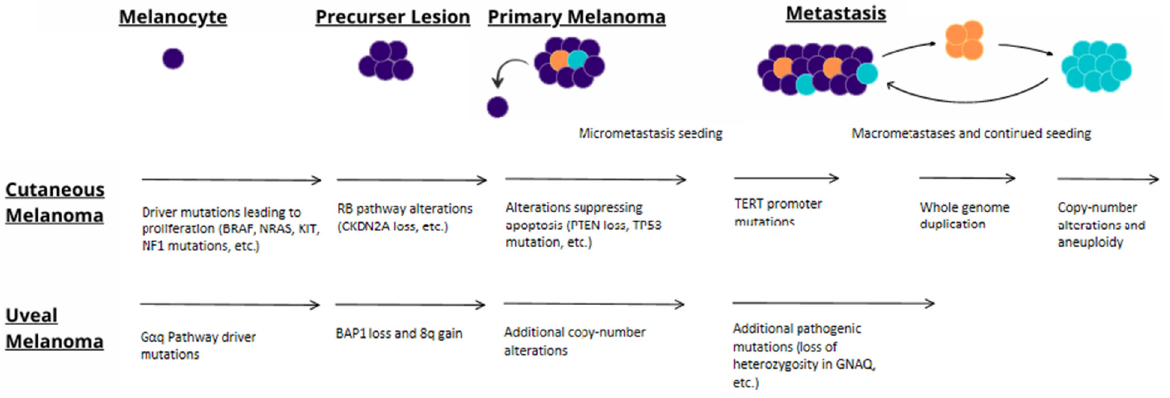
Figure 2. Proposed model of progression to metastasis for cutaneous and uveal melanoma.